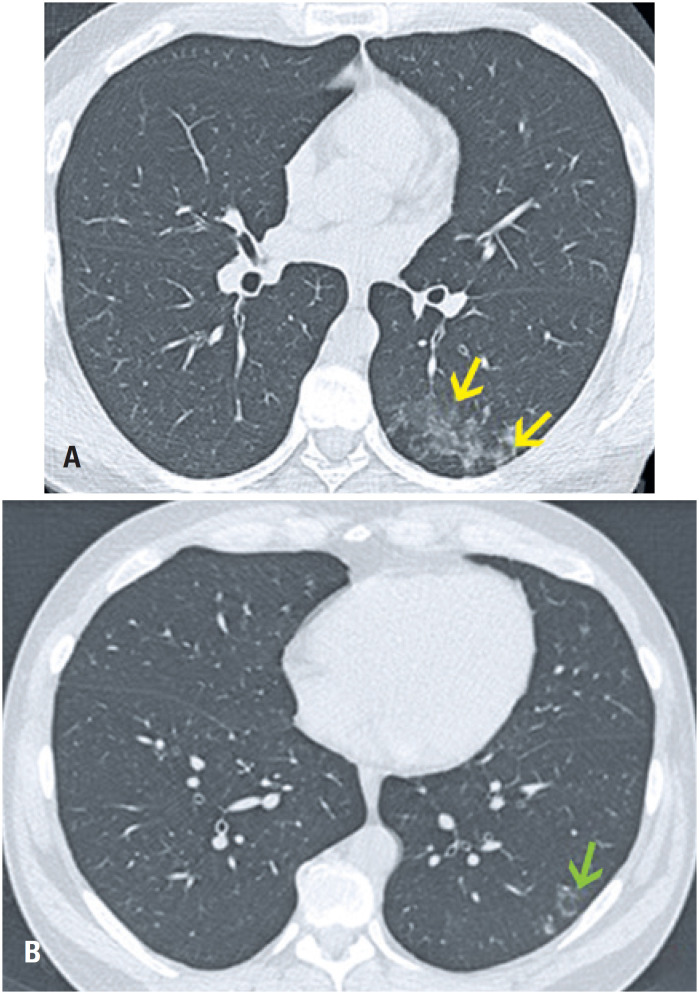
Homem, 44 anos, tabagista, realizou o primeiro exame (A) Para
check-up
. Após 10 meses, realiza o segundo exame (B) Devido à tosse e a mal-estar. (A) Tomografia computadorizada com plano de corte axial da janela pulmonar: opacidades centrolobulares em vidro fosco por vezes confluentes, esparsas pelo lobo inferior esquerdo; (B) Tomografia computadorizada com plano de corte axial da janela pulmonar: redução da densidade das opacidades centrolobulares em vidro fosco – algumas exibindo sinal do halo invertido (seta verde)